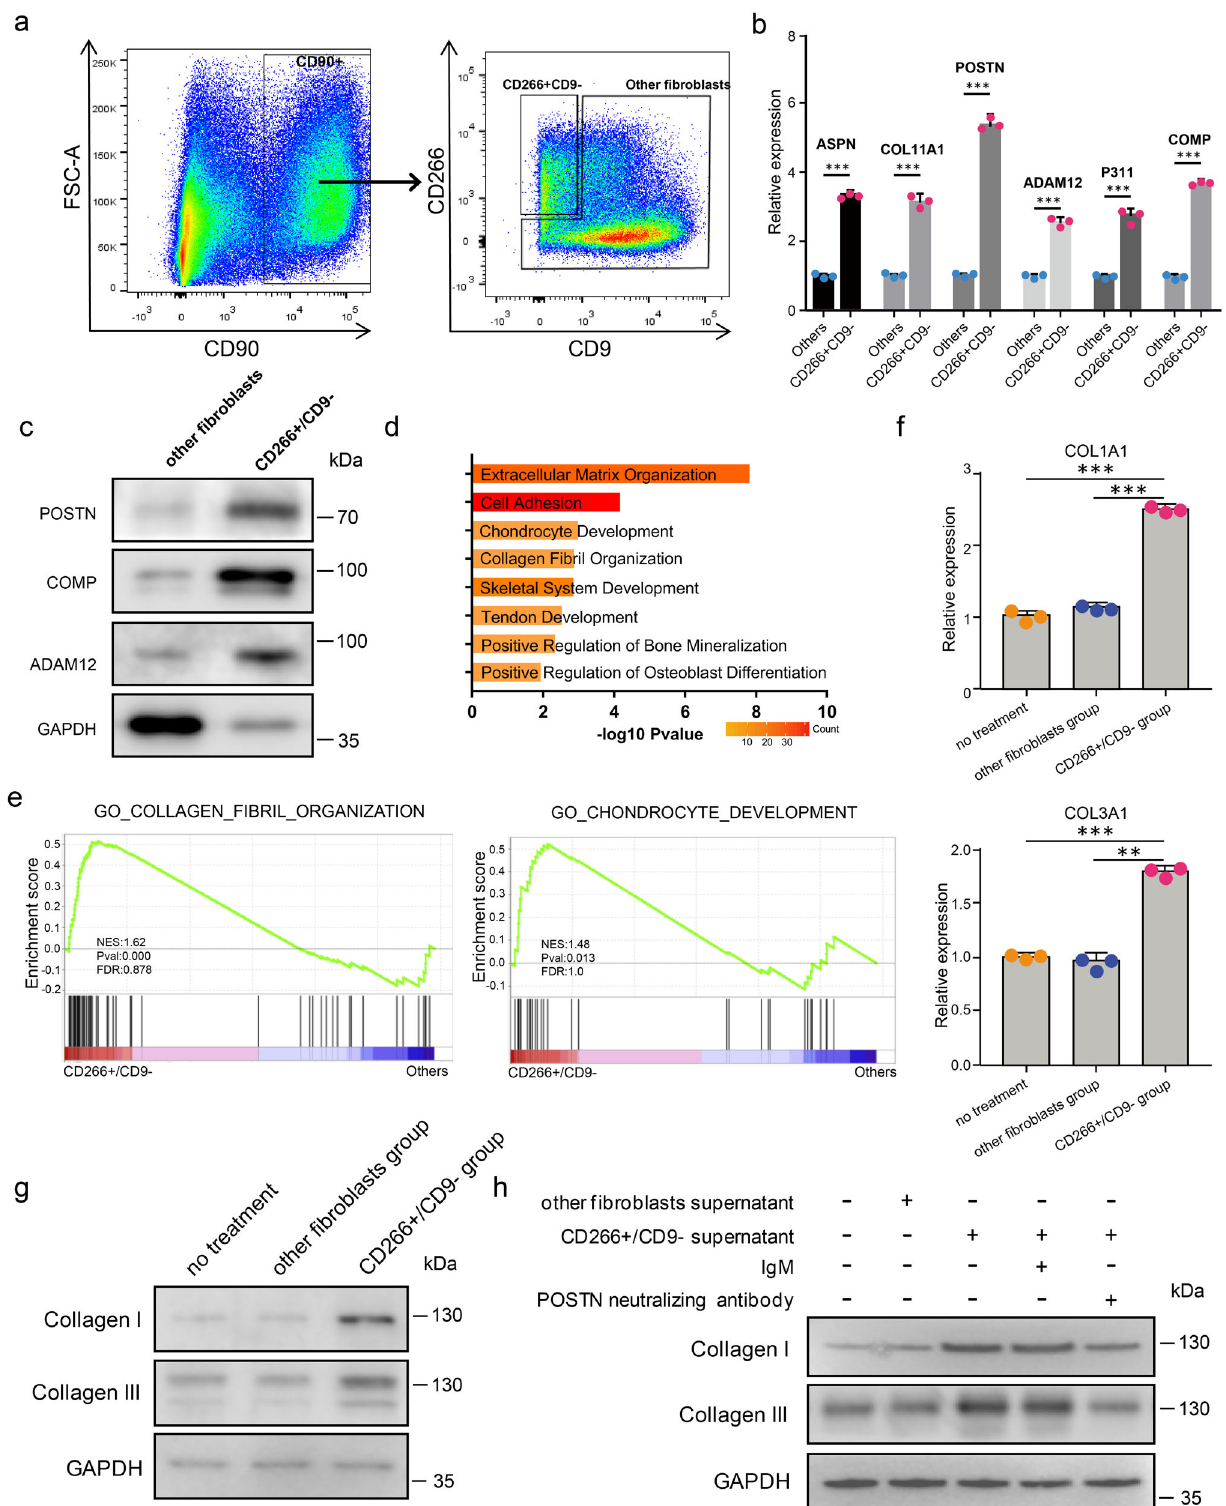
neutralizing antibodies inhibited the increase of collagens in other fi broblasts treated with mesenchymal fi broblast supernatant (Fig. 5h), indicating that these interactions are important for keloid collagen overexpression and may serve as therapeutic